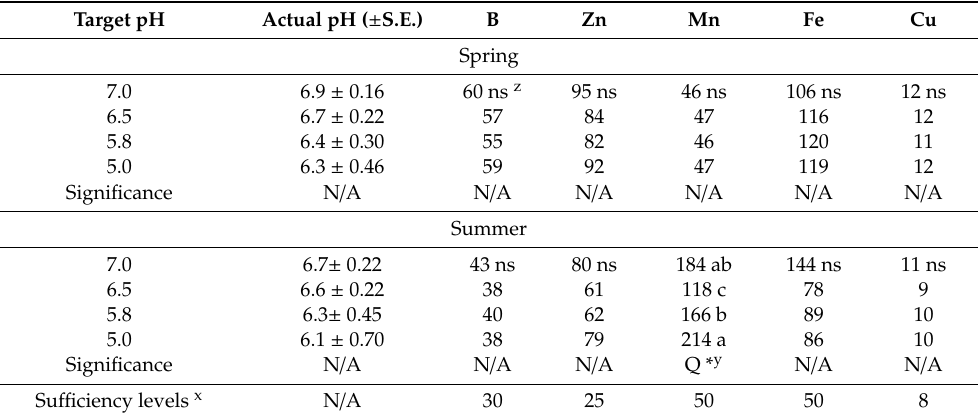
Table 8. Midseason foliar analysis of micronutrients as percent mg · kg –1 percent dry matter for aquaponic cucumbers at four pH